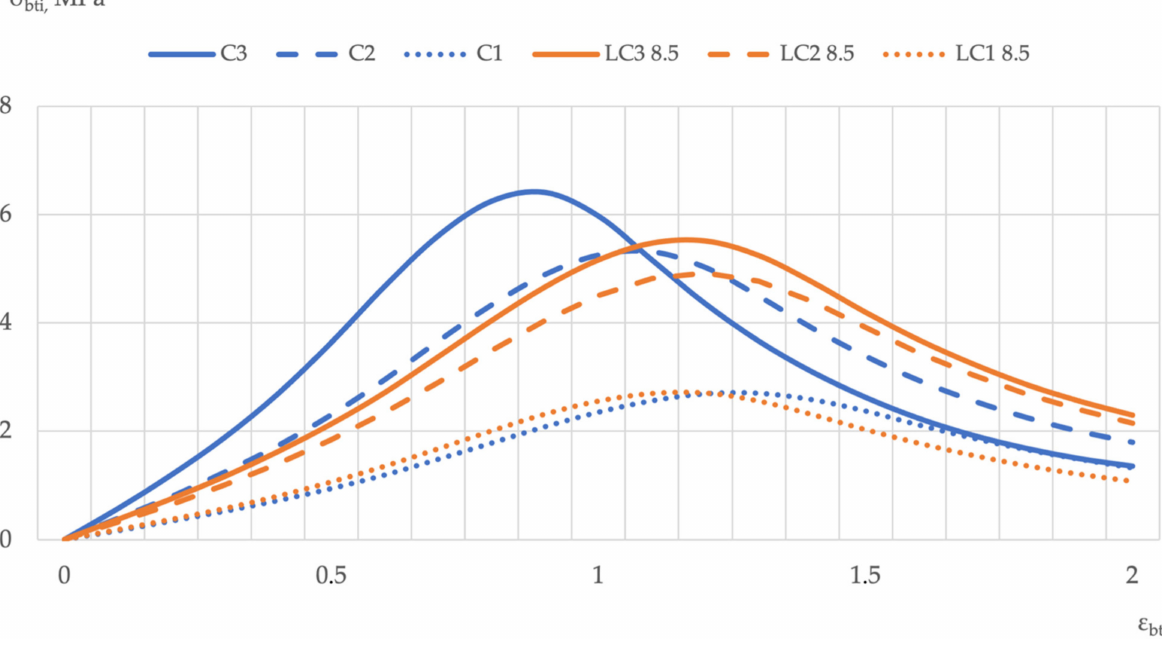
Figure 11. Diagram “stress—strain” in tension for the differential characteristics of vibro-centrifuged concrete (see Figure 10; C1, C2, C3—respectively the inner, middle, and outer layer of the control concrete composition; LC1 8.5, LC2 8.5, LC3 8.5—respectively the inner, middle, and outer layer lightweight concrete on activated water with pH =